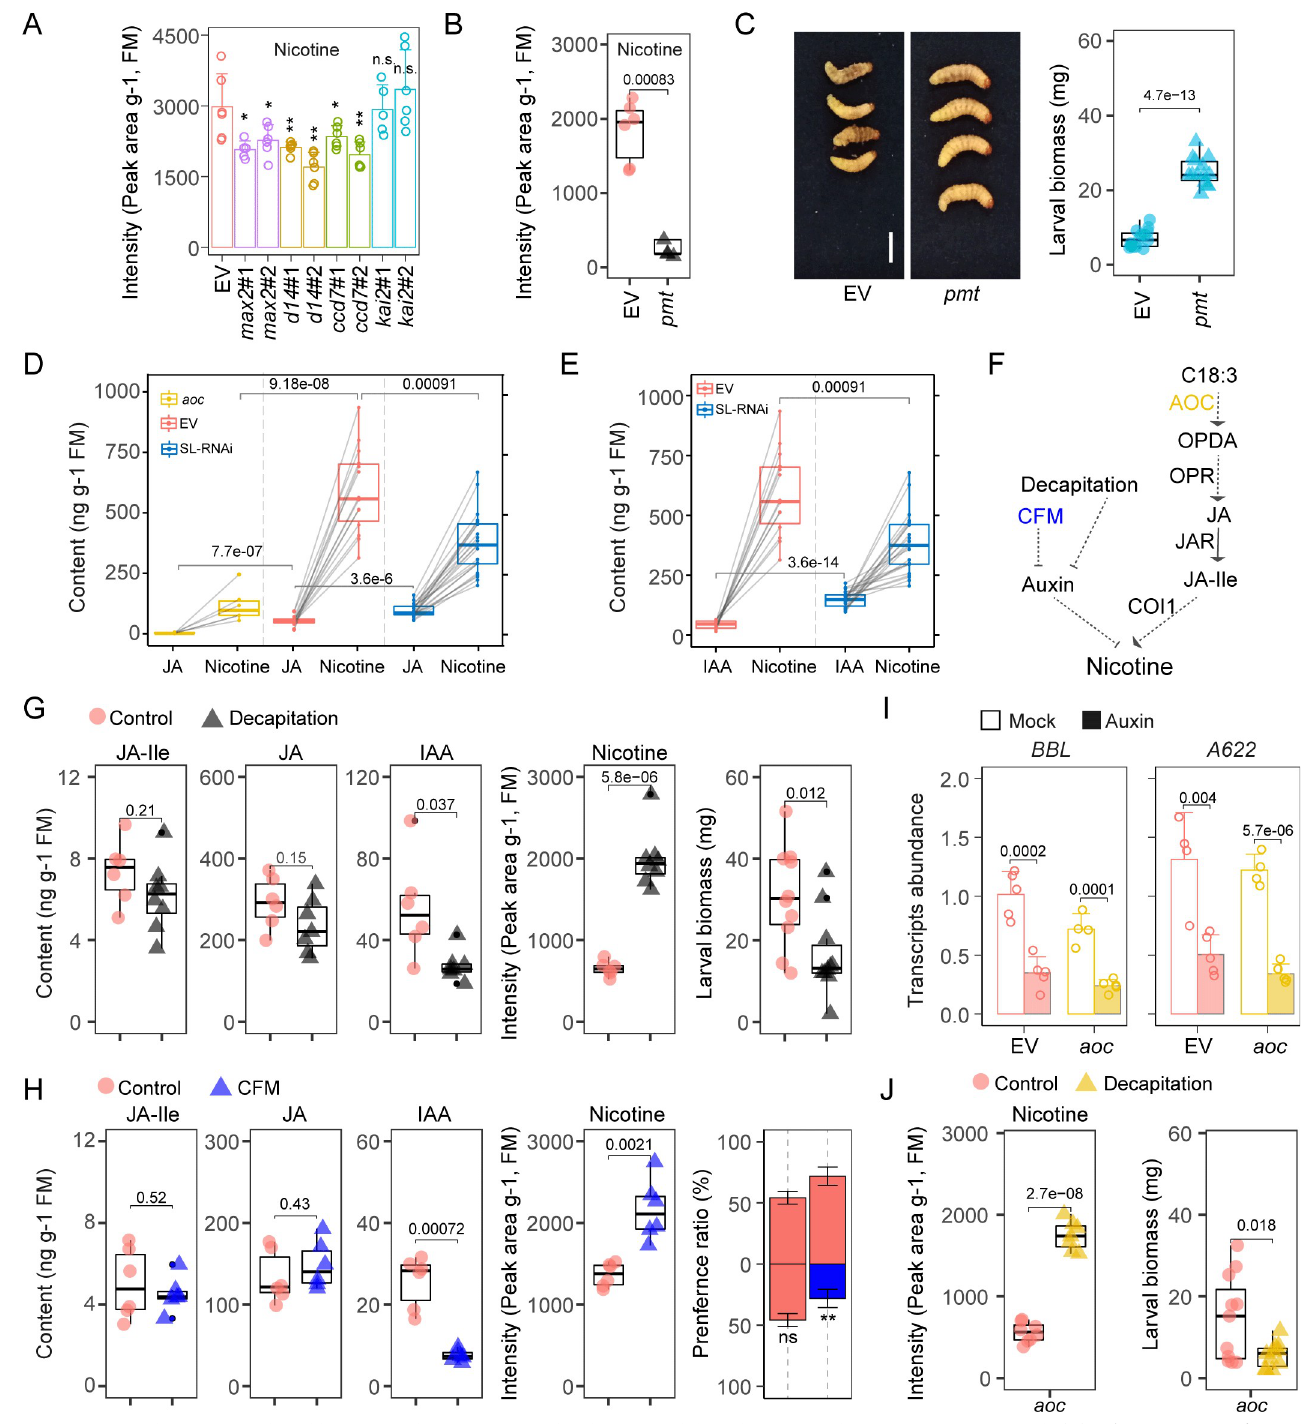
Fig 8. Decreased nicotine mediated by increased auxin accounts for the susceptibility of SL-RNAi plants to T . mucorea attack. (A) Relative contents of nicotine in the RSJs of indicated plants ( ± SE, n = 6). (B) Relative levels of nicotine in the pith of EV and pmt plants ( n = 6). (C) Representative pictures and biomass of T . mucorea larvae after attacking EV and pmt plants for 2 weeks ( n = 15). Scale bar, 2 mm. (D) Relationship of JA and nicotine levels in RSJ of aoc , EV, and SL-RNAi ( max2 , d14 , and ccd7 ) plants. Data collected from same samples are indicated by gray lines. (E) Relationship of IAA and nicotine levels in RSJ of EV and SL-RNAi ( max2 , d14 , and ccd7 ) plants. Data collected from the same sample are connected with a gray line. (F) Schematic diagram of nicotine biosynthesis regulated by auxin and JA-Ile. (G) Levels of JA-Ile, JA, and IAA in roots of EV plants without (Control) or with decapitation treatment for 3 days ( n = 6–8). Nicotine content in the RSJs of EV plants with or without decapitation treatments for 3 days ( n = 5–6). Biomass of larvae that had attacked intact or decapitated